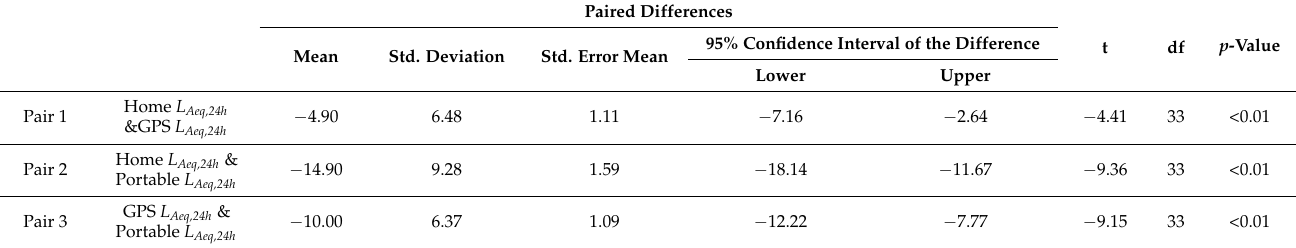
Table 6. Paired sample t -test between the three measures of individual noise exposure. Paired